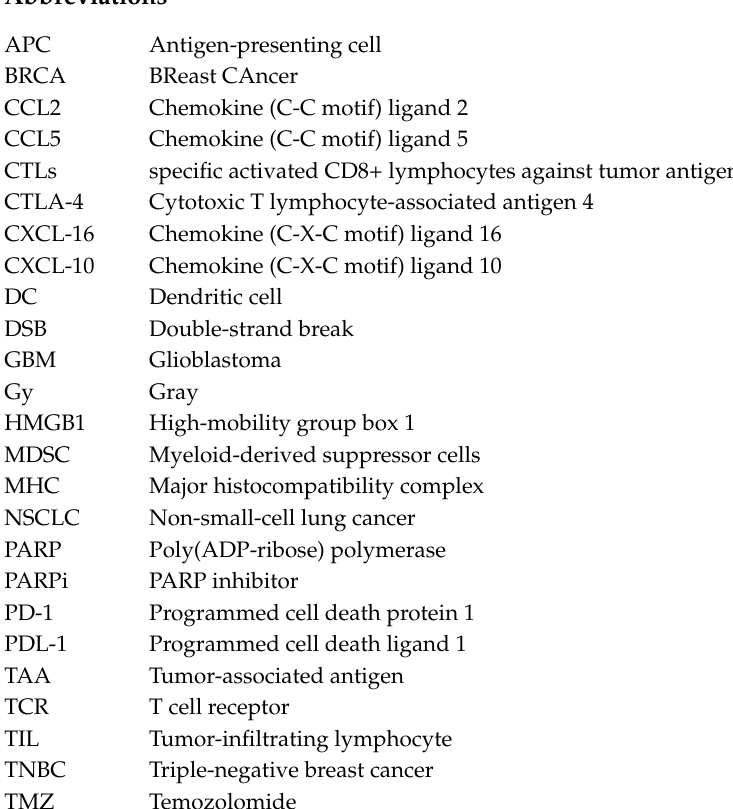
Table S2: Development of PARPi in association with immunotherapy; Table S3: Association between external radiation therapy and immunotherapy; Table S4: Clinical trials evaluating the combination of PARPi and radiation in various